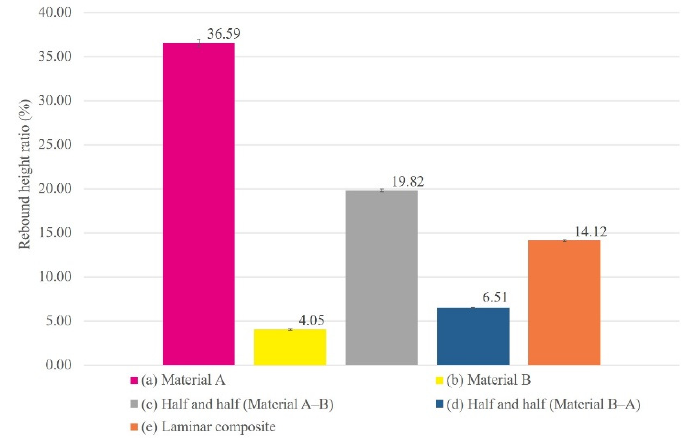
Figure 14. Average rebound height ratios.